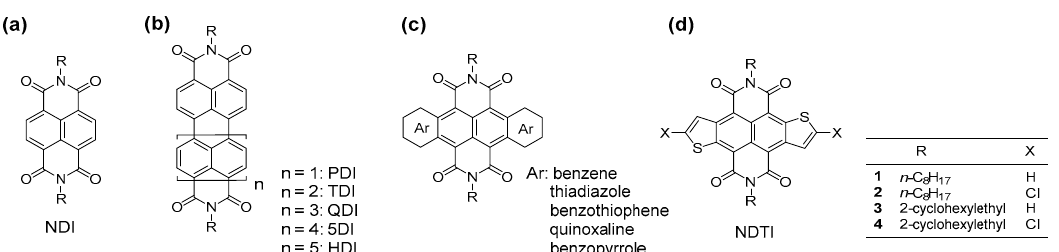
Figure 1. Molecular structures of semiconducting molecules based on naphthalene diimide (NDI, a ); rylene diimides ( b ); core-extended NDIs ( c ); and naphtho[2,3- b :6,7- b ′ ]dithiophene-4,5,9,10-tetracarboxylic diimide (NDTI, d ).